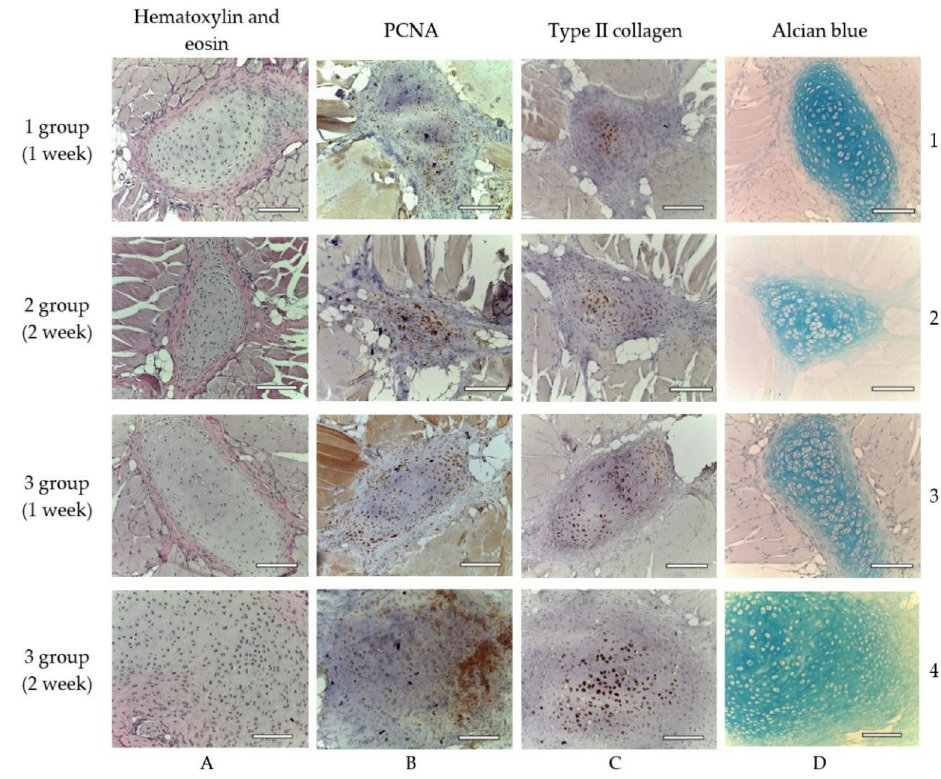
Figure 8. Cartilage tissue in animals of different experimental groups, objective lens × 20, scale bar—100 µ m. Explanation in the text. ( A1 – D1 )—1st group (dECM only), 1 week; ( A2 – D2 )—2nd group (MSC only), 2 weeks; ( A3 – D3 )—3rd group (dECM and MSC), 1 week; ( A4 – D4 )—3rd group (dECM and MSC), 2 weeks. ( A )—staining with hematoxylin and eosin; ( B )—staining for PCNA;